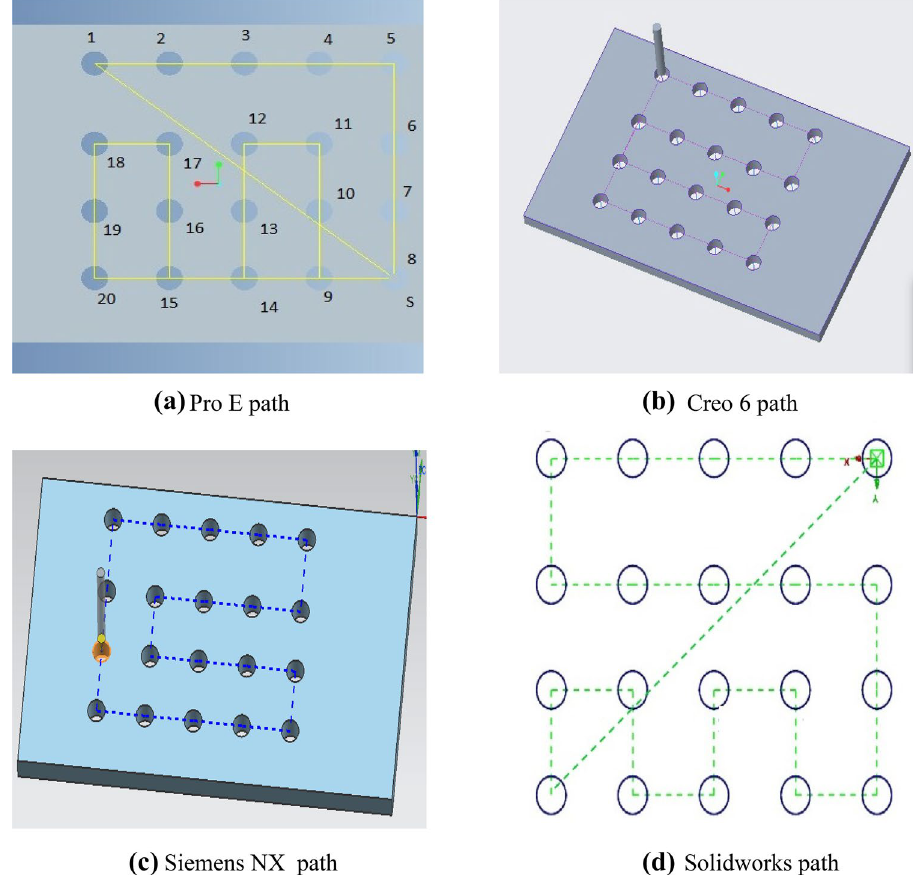
Fig. 4 Optimal paths through CAM softwares. a Pro E path b